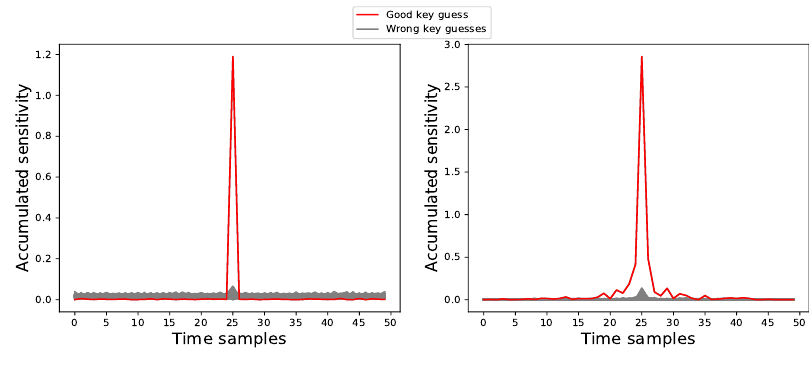
Figure 5: Inputs-based sensitivity accumulated over 50 epochs for all key guesses. Left: with MLP sim network. Right: with CNN sim network.